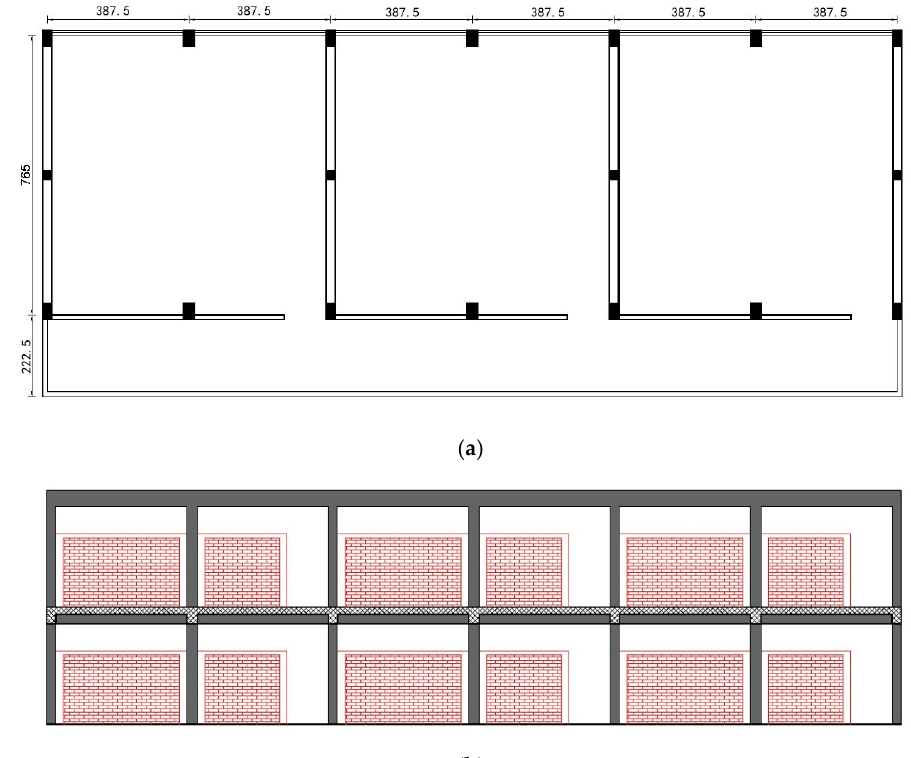
Figure 2. Characterization of existing buildings: PREbuilding type.